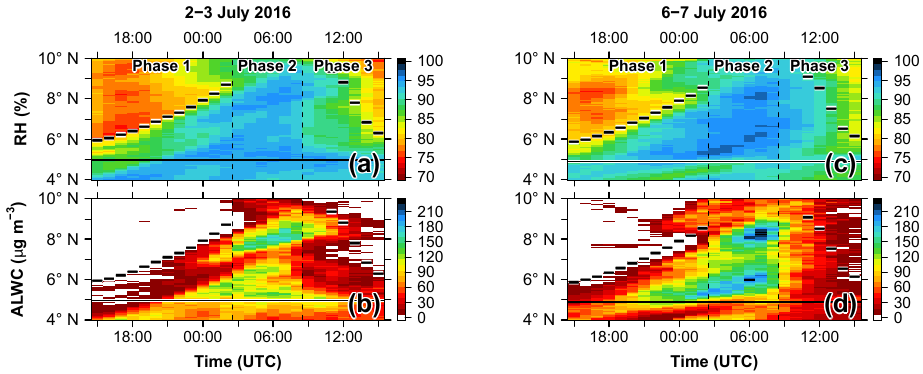
Figure 3. Hovmöller diagram of the median (a, c) RH (%) and (b, d) total ALWC (µgm − 3 ) in the lowest 1500ma.g.l. as a zonal mean over the Ivory Coast (7.5–3 ◦ W, 4–10 ◦ N) (left) between 2 July 15:00UTC and 3 July 15:00UTC and (right) between 6 July 15:00UTC and 7 July 15:00UTC. The horizontal bars denote the zonal mean location of the 302K isentrope at 250ma.g.l., the horizontal solid line the zonal mean coastline and the vertical dashed lines separate the three phases: the AI progression phase (Phase 1), the moist morning phase (Phase 2) and the daytime drying phase (Phase